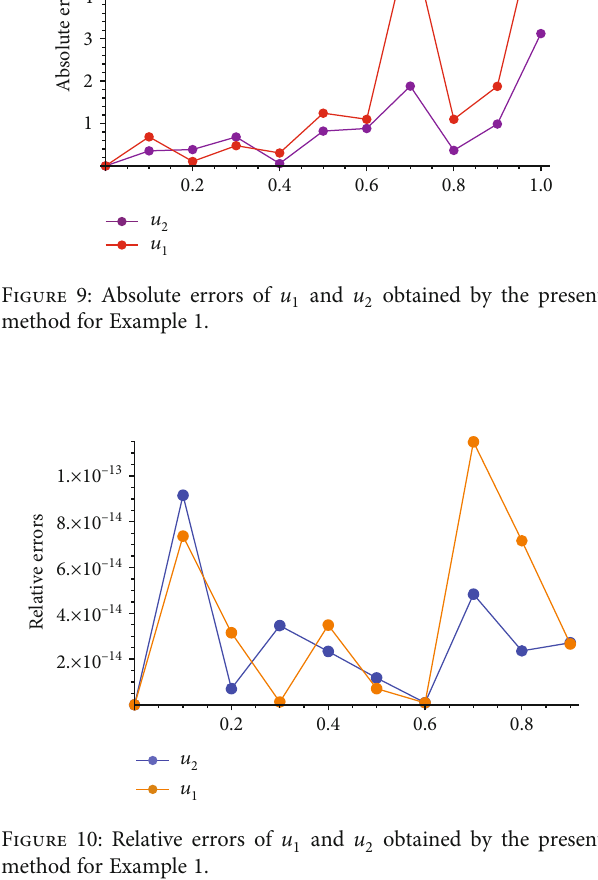
Figure 7: Comparisons between numerical and exact solutions of u obtained by the present method for Example 1.